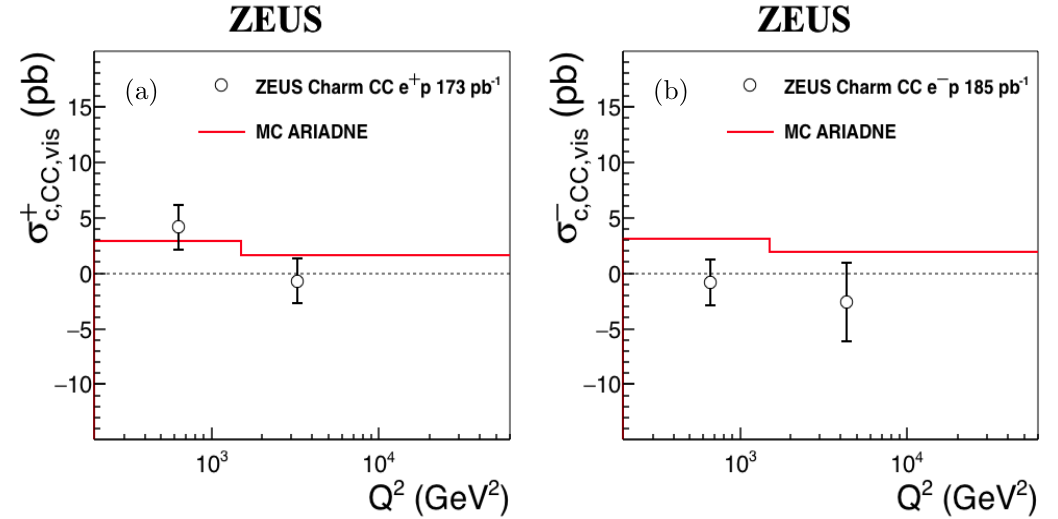
Figure 9. The visible charm cross sections, (cid:27) c; vis , in two bins in Q 2 for (a) e + p and (b) e (cid:0) p collisions. The vertical error bars show the total uncertainties; the systematic uncertainties are negligible. The solid lines represent predictions obtained with the ARIADNE